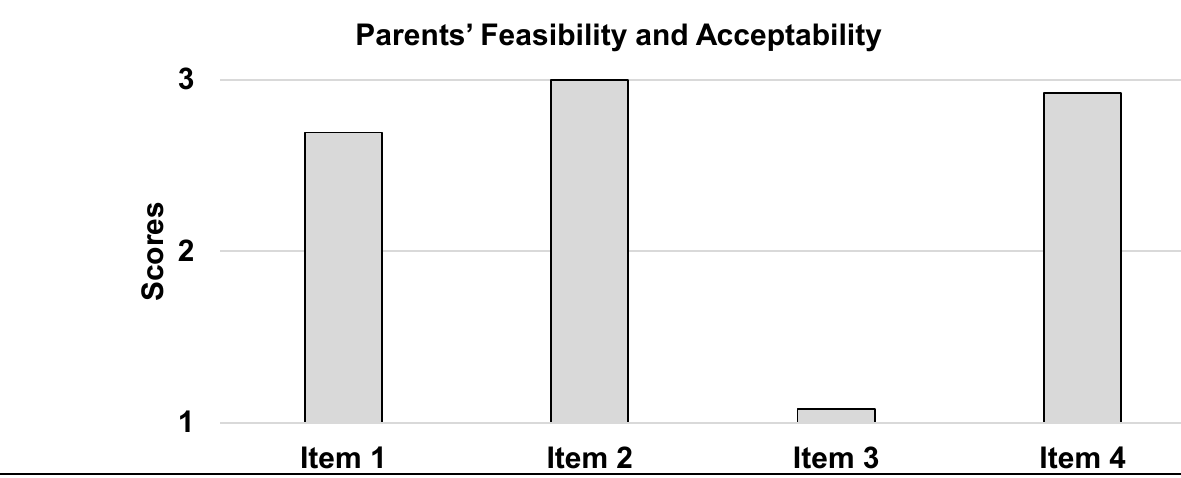
Parents’ Questionnaire Scores: Feasibility and Acceptability of Overall Telemedicine